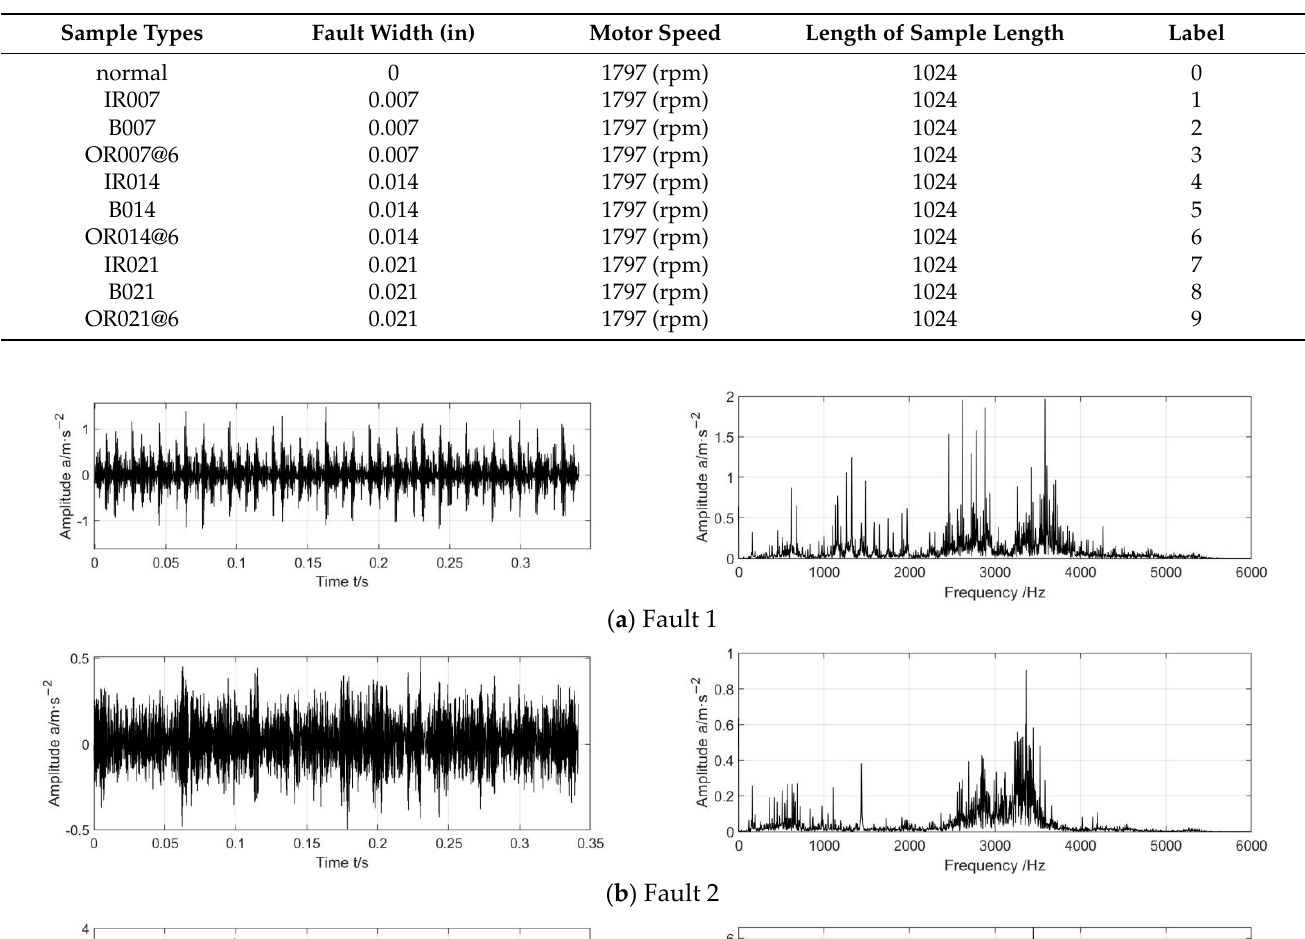
Table 3. Experimental sample information.